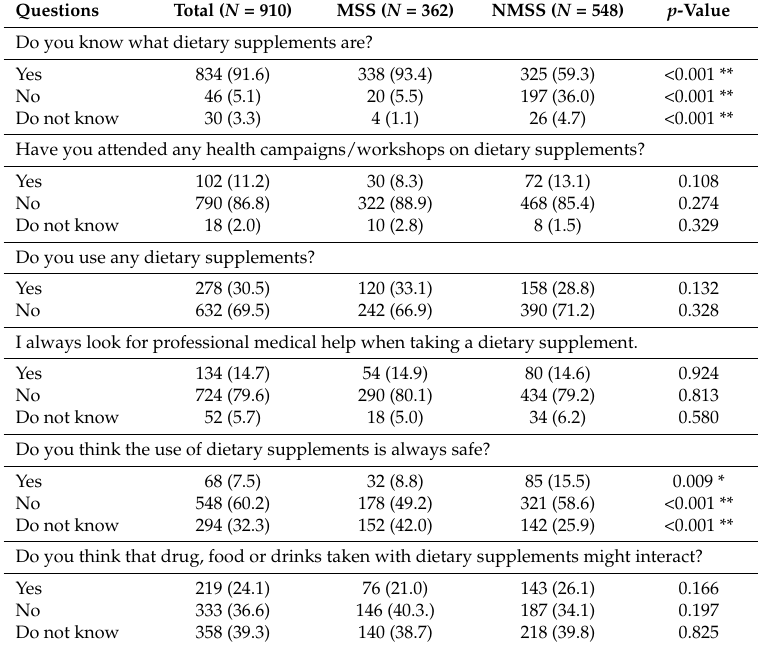
Table 2. Questionnaire used to determine knowledge, attitudes and practices regarding